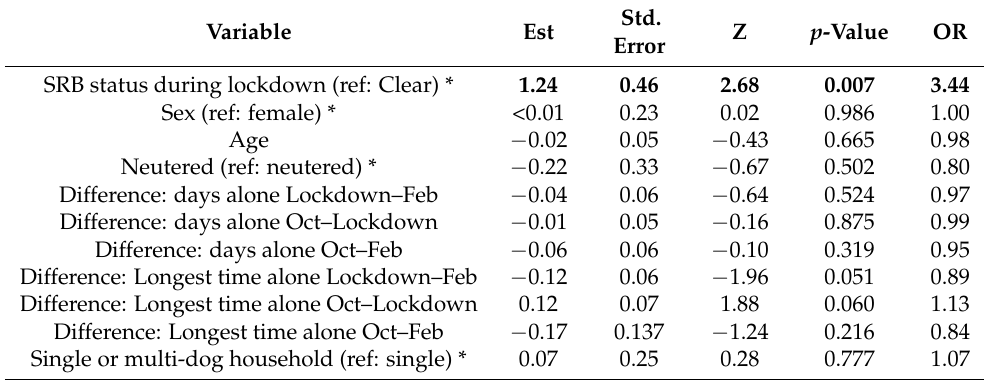
Table 3. Results from univariable logistic regression models for n = 400 dogs who were SRB+ in February 2020. The dependent variable is SRB status in October 2020, of which n = 143 were classified as still SRB+ but n = 180 had transitioned to being Clear, and n = 77 were not being left so had a missing SRB status. Text in bold highlights variables significant to p < 0.05. * Denotes variables treated as categorical. Unless otherwise indicated, variables were treated as